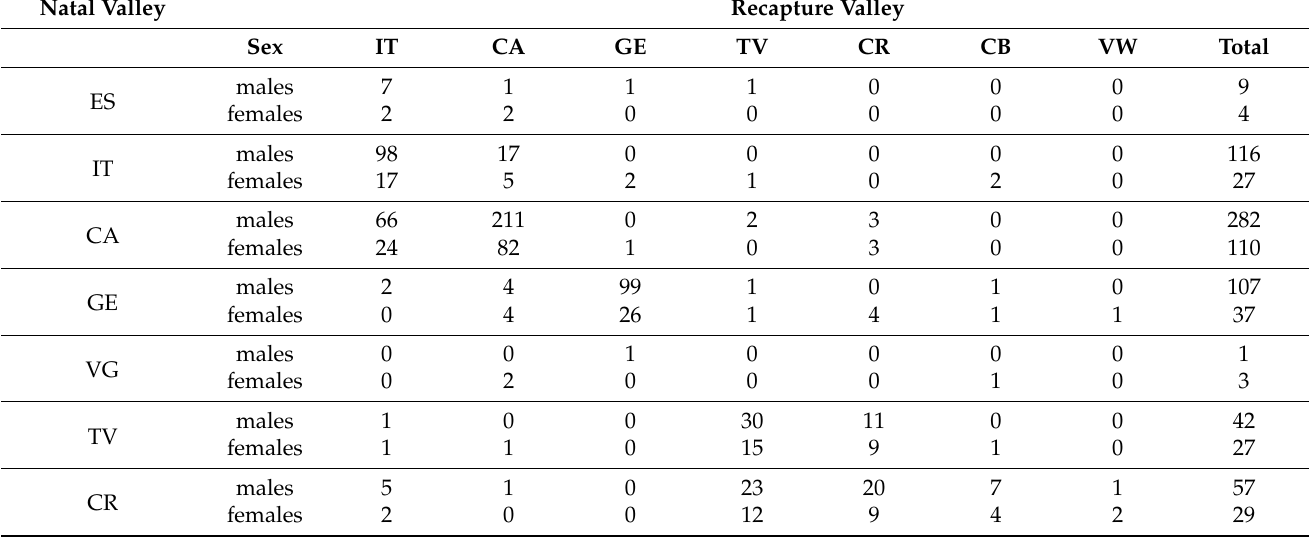
Table 1. Heermann’s Gull individuals banded and recaptured on Rasa Island ( n = 998). Individuals were banded at “Natal Valleys” and recaptured at either the same valley or at other “Recapture Valleys”: IT, Vallecito del Estero; CA, Valle de la Casita; GE, Gran Estaci ó n Central; TV, Tapete Verde; CR, Casitas Viejas Arriba; CB, Casitas Viejas Abajo; and VW, Valle de la W. Valle del Estero and Valle de los Gallitos valleys were not monitored after